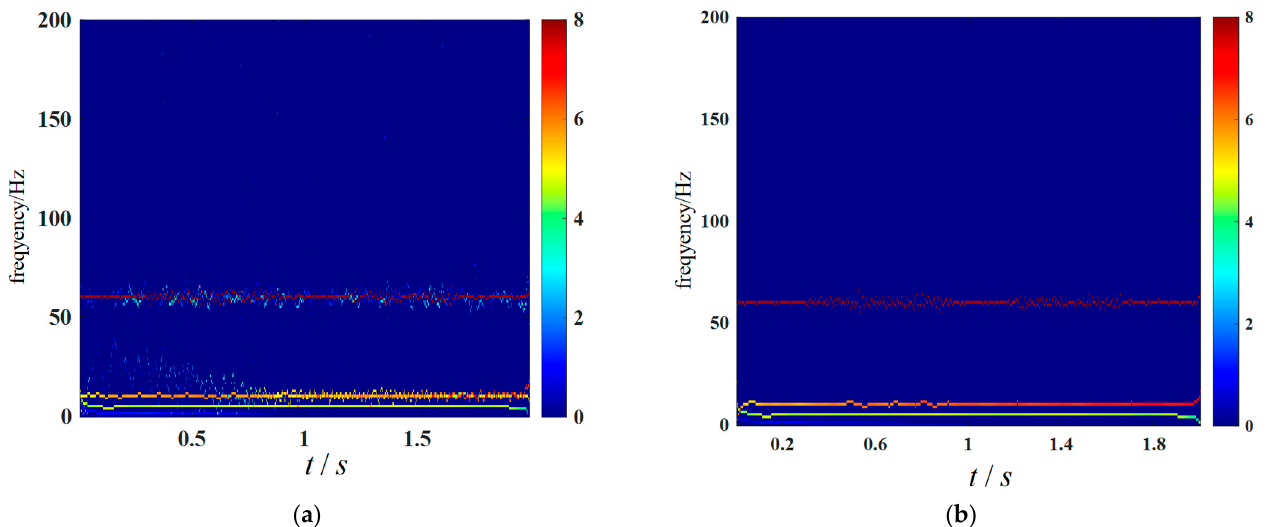
Figure 6. Correlation coefficients of the original simulation signal decomposition results of the two methods.